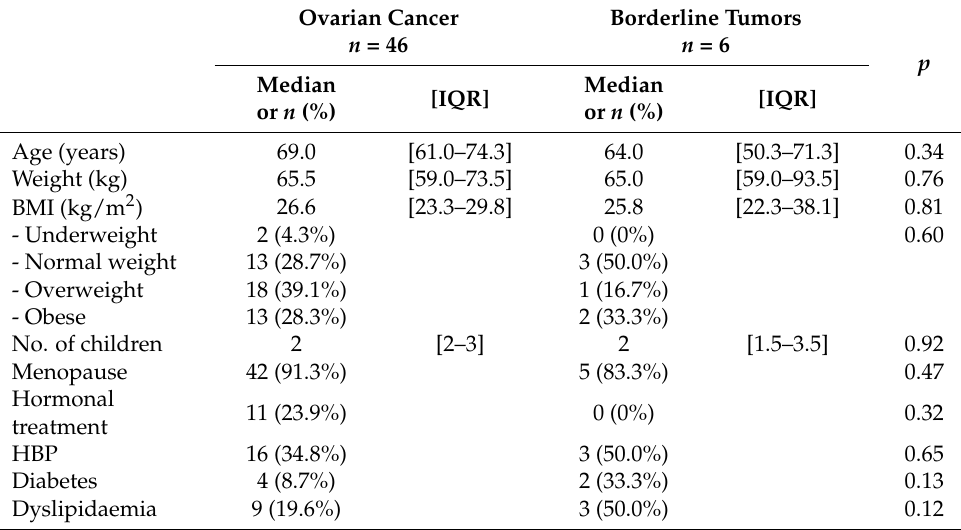
Table 1. Demographic and histological characteristics of women included in the